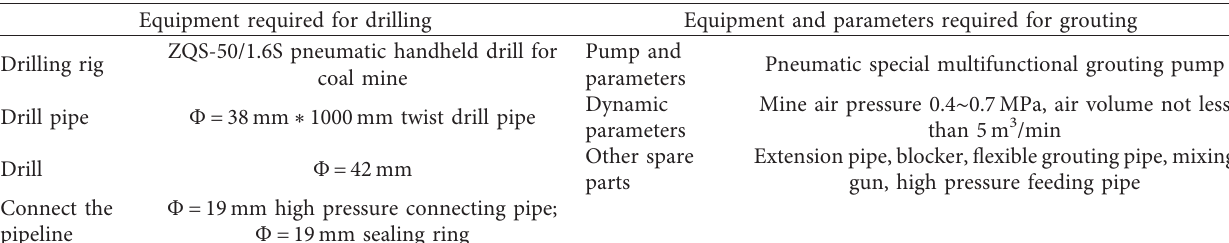
Table 2: Equipment and materials required for drilling construction. Equipment required for